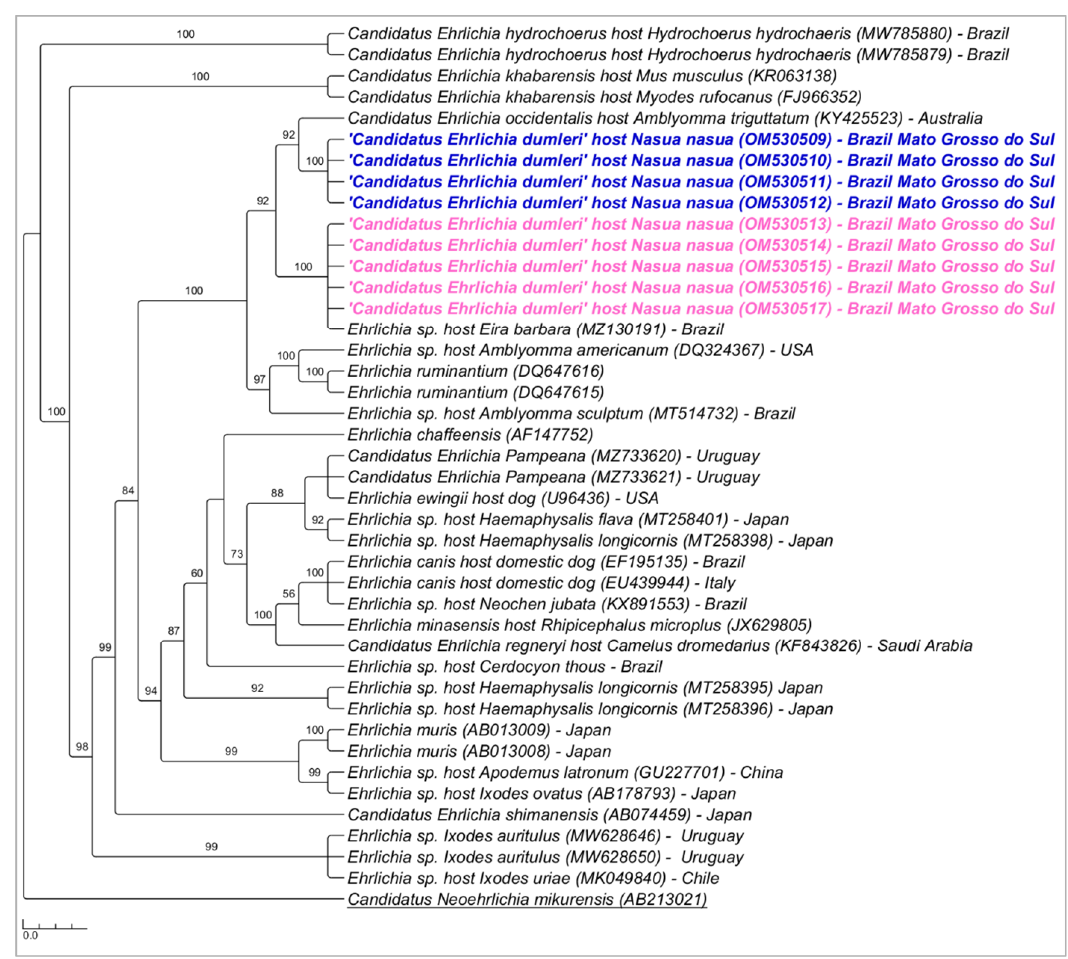
Figure 2. Phylogenetic tree inferred by the Bayesian method and based on the 16S rRNA gene from Ehrlichia spp. sequences obtained from blood from ring-tailed coatis ( Nasua nasua ) sampled in Campo Grande city, Mato Grosso do Sul state, Brazil. Sequences detected in the present study are highlighted in bold blue (PEP—genotype 1) and pink (VBA—genotype 2).